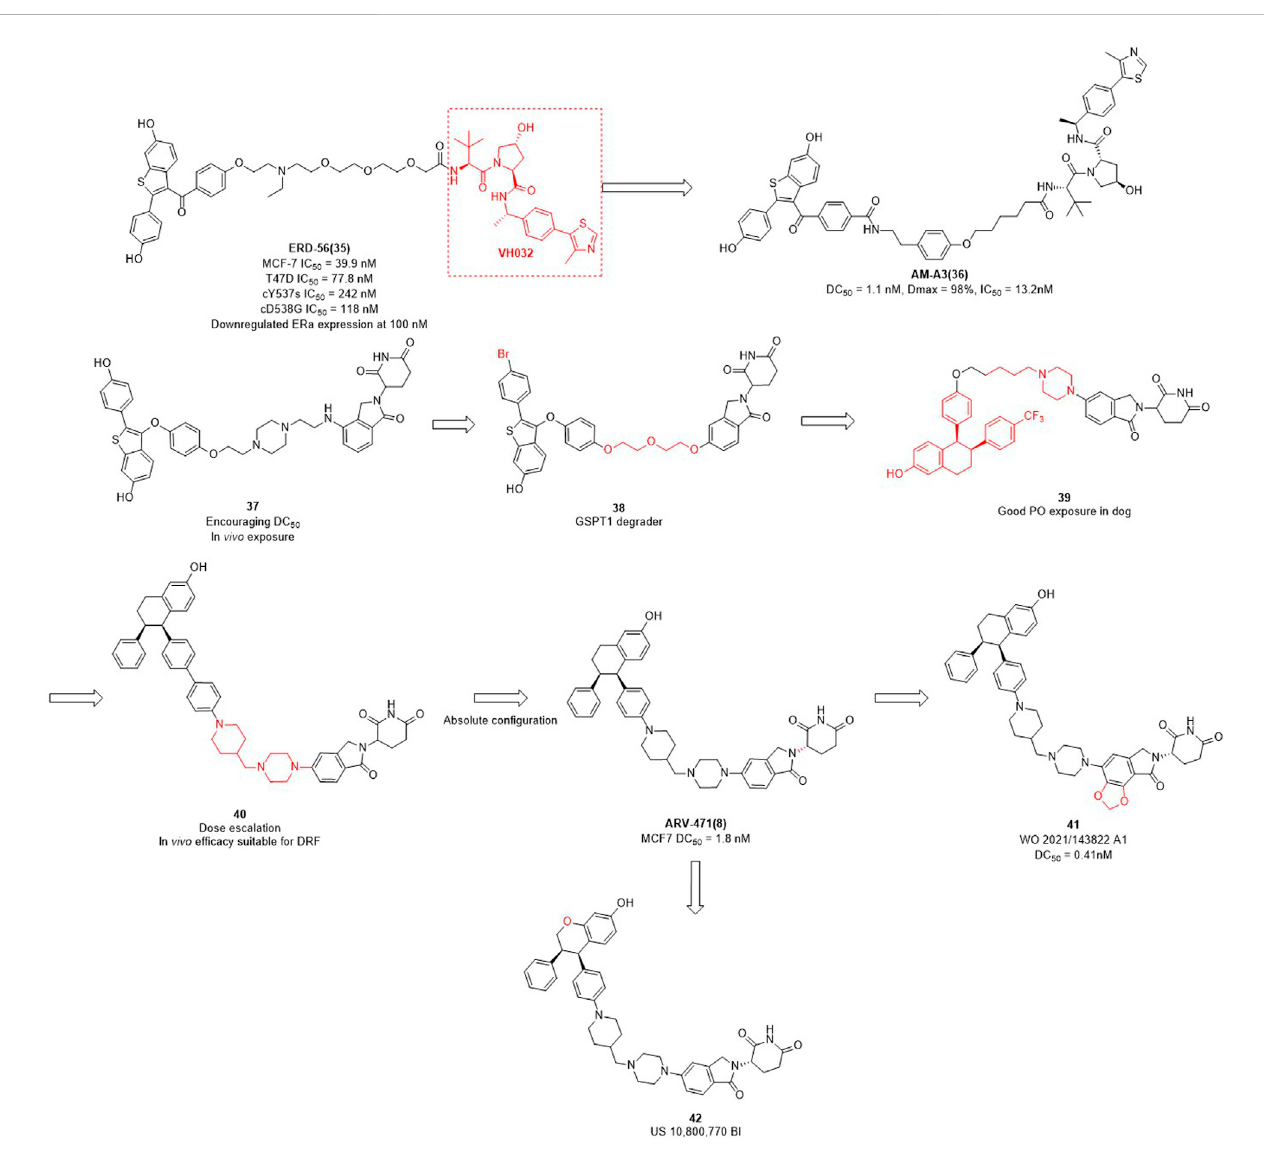
FIGURE 3 Design and optimization process of ER